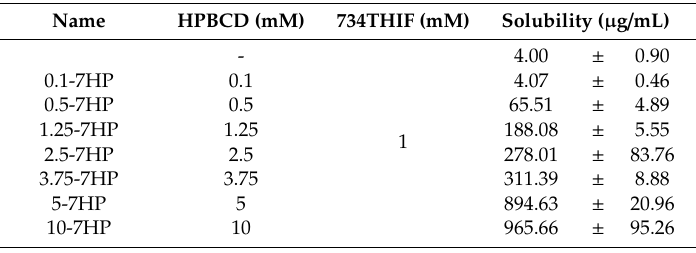
Table 3. Solubility of different ratios of 7HP.